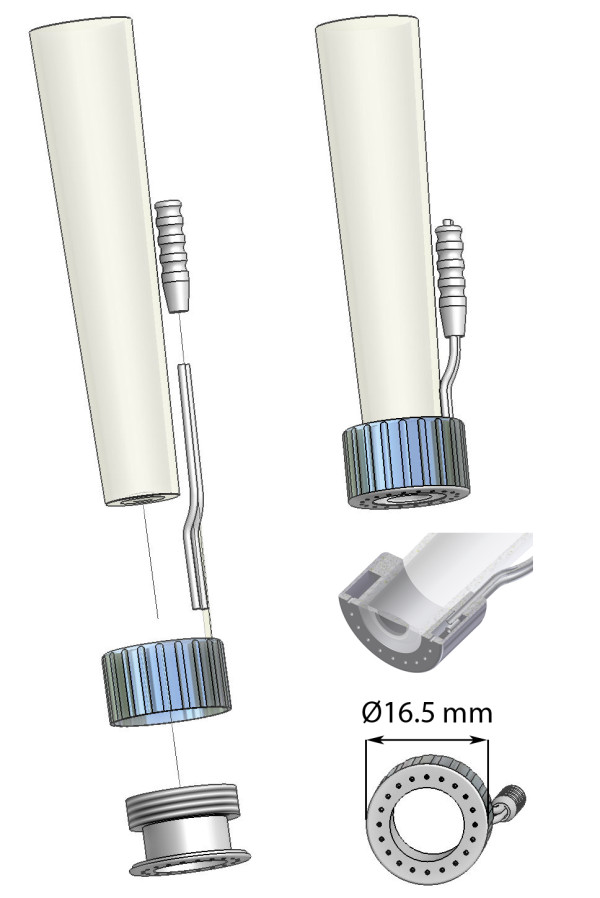
Image Acquisition Stabilizer. The sterile Sidestream Dark Field (SDF) imaging cover with the image acquisition stabilizer (IAS) in exploded view (left), attached view (upper right), crosssectional view (middle right), and bottom view (lower right).